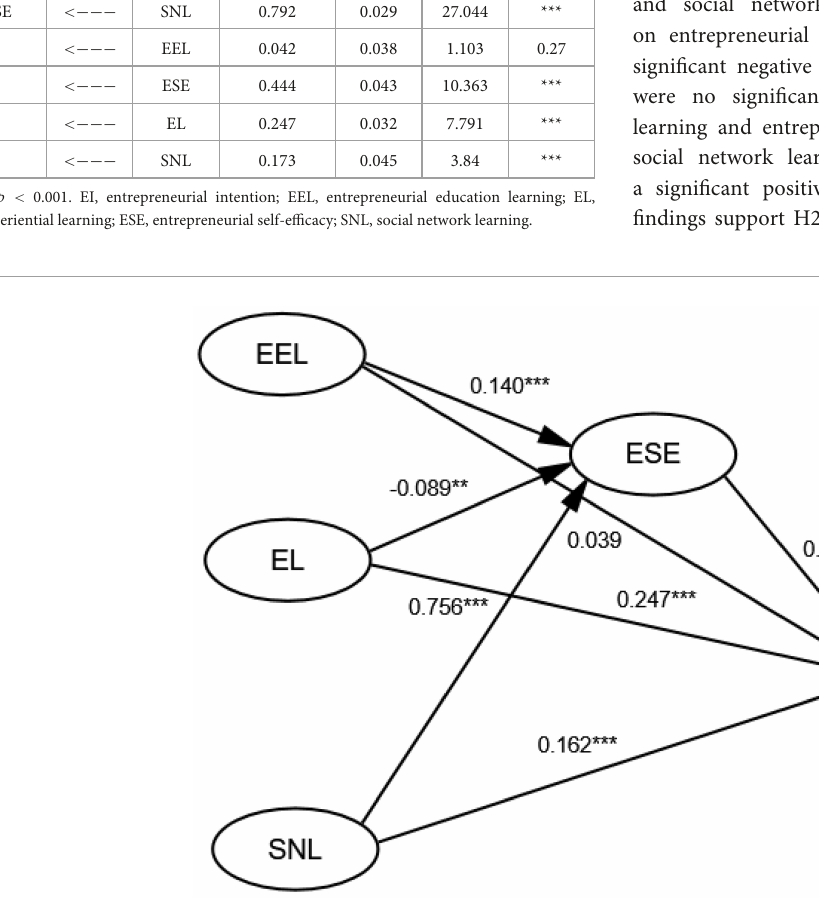
FIGURE3 Structural equation model results: path diagram. EI, entrepreneurial intention; EEL, entrepreneurial education learning; EL, experiential learning; ESE, entrepreneurial self-efficacy; SNL, social network learning. ∗∗ p < 0.01 and ∗∗∗ p <